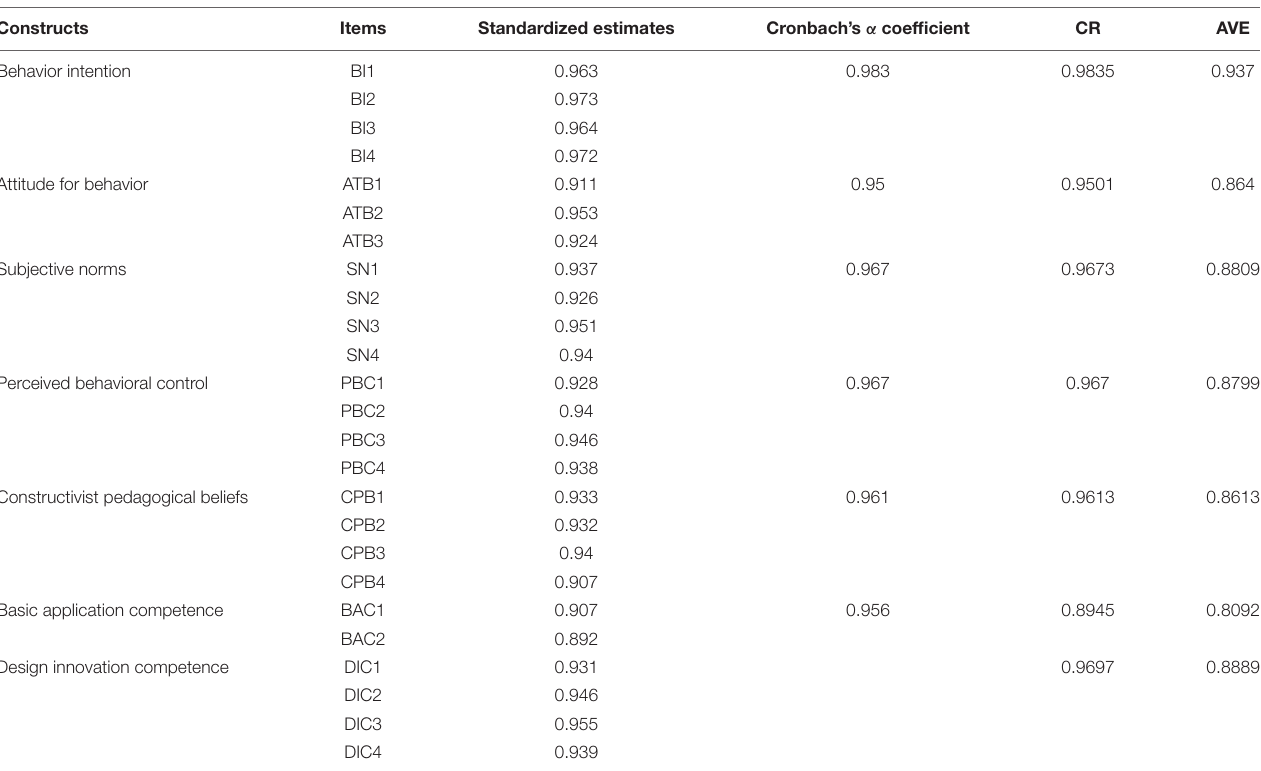
TABLE 1 | Results of the confirmatory factor